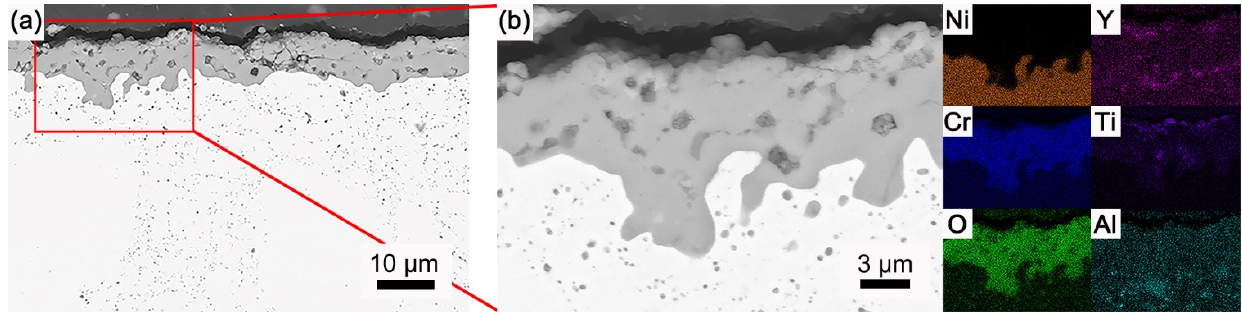
Figure 7. Cross ‐ sectional SEM micrograph at ( a ) low magnification and ( b ) high magnification and element distribution of oxide scale on S2 after oxidation in air at 1000 °C for 200 h.